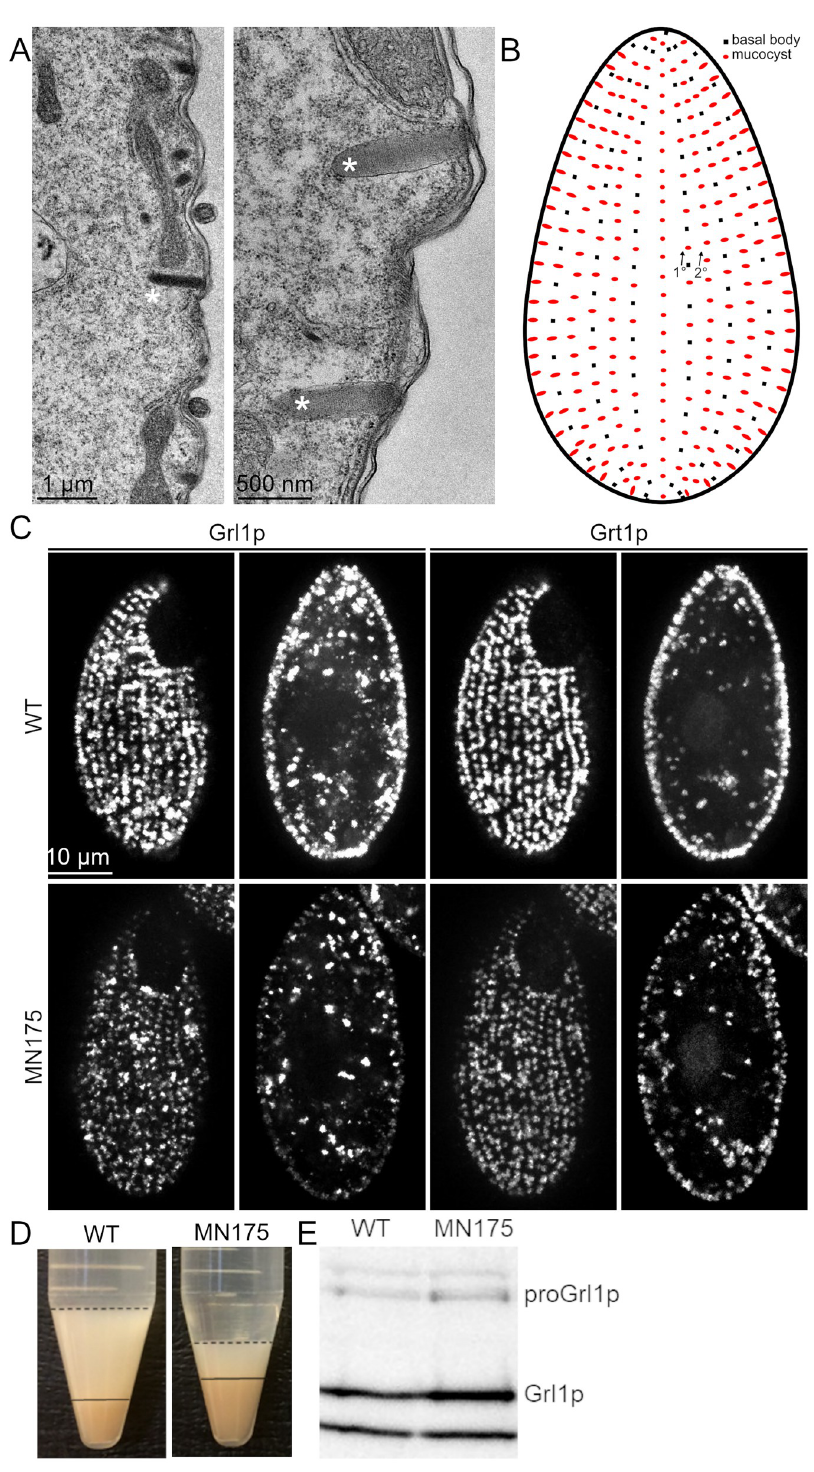
Fig 1. Mucocyst accumulation, docking and secretion. A. Thin section electron micrographs of mucocysts in WT cells. The large majority of mucocysts (marked with � ) are docked at the plasma membrane. The electron-dense contents are organized as a protein crystal, more easily seen at high magnification (right panel). Scale bars are indicated. B. Cartoon of a Tetrahymena cell, highlighting that the docked mucocysts (red) are aligned along cytoskeletal ‘ribs’ called 1˚and 2˚meridians. On the former but not the latter, mucocysts are interspersed with